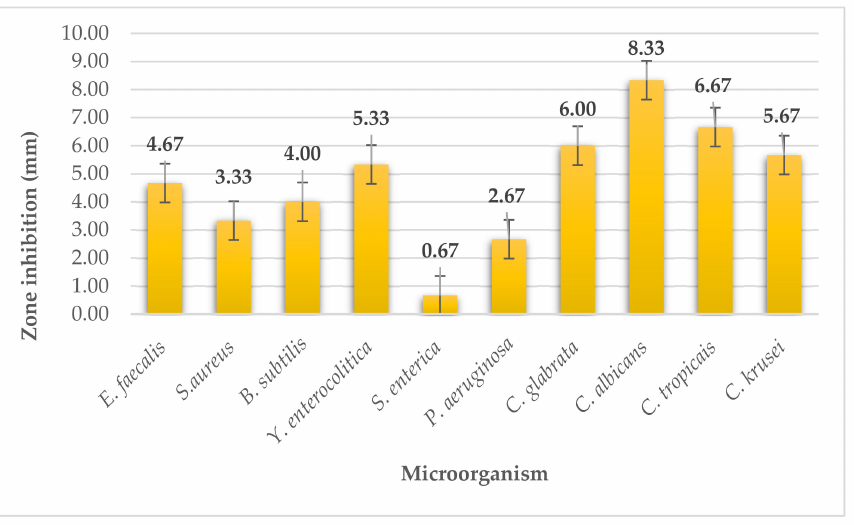
Figure 5. Antimicrobial activity of wakame. Algae wakame or Undaria pinnatifida had similar minimum inhibitory concentrations against G + , G − bacteria, and yeasts. The MICs ranged from MIC 50 54.32 (MIC 90 55.18) to MIC 50 6.23 µ L/mL (MIC 90 8.36 µ L/mL) for the selected microorganisms (Figure 6). The wakame algae extract was most effective against Bacillus subtilis where MIC 50 6.23 µ